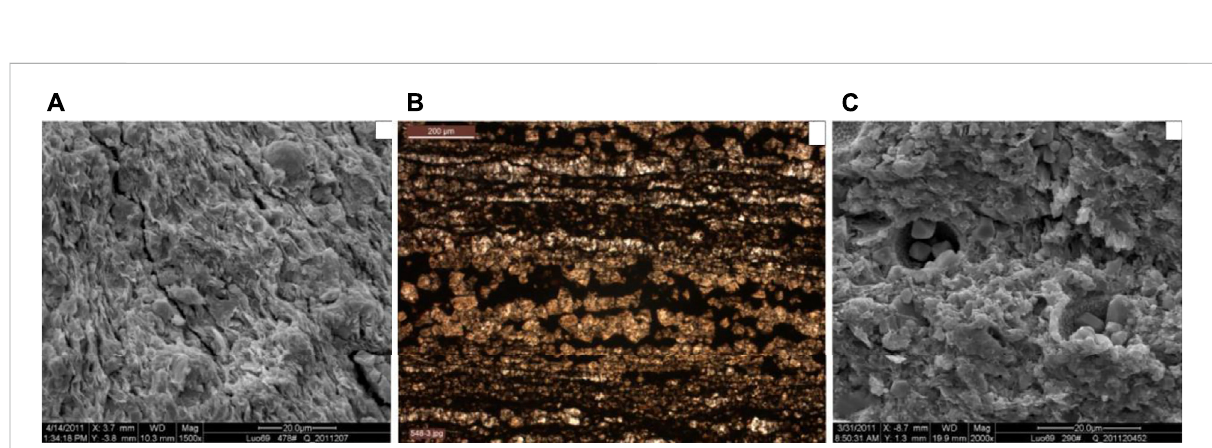
FIGURE 7 Typeandcharacteristicsofshaleporethroat. (A) WellLuo69,3,039.60 m,sheetmicroporedevelopment;seestrawberrypyrite. (B)